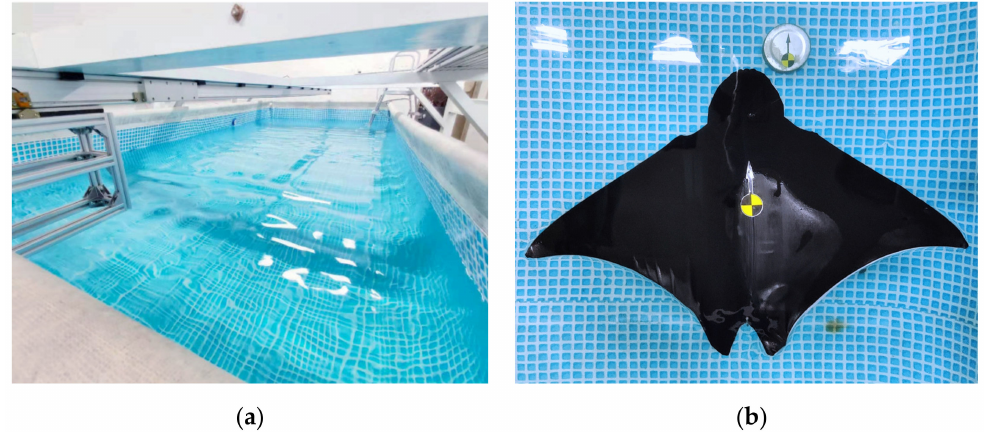
Figure 8. Environment of swimming performance tests. ( a ) Cruising speed test; ( b ) steering speed and radius